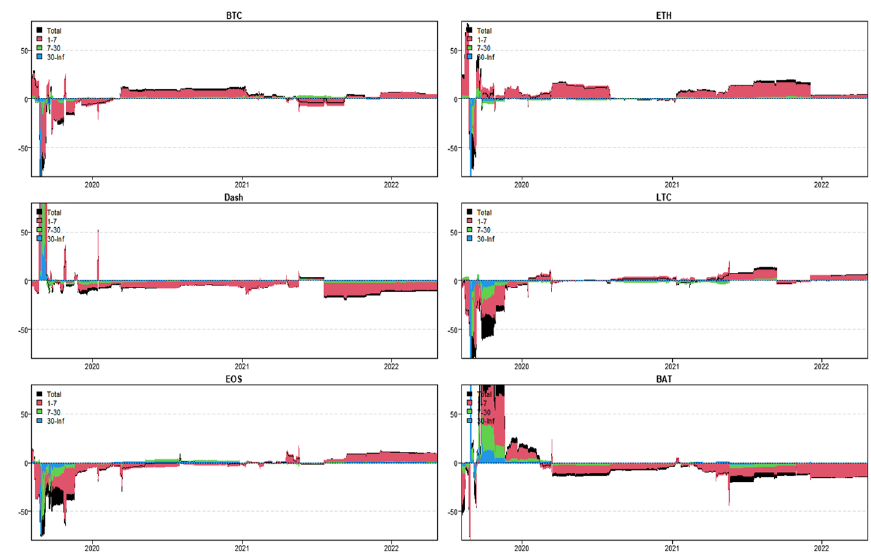
Fig. 14 Dynamic net connectedness—signed jump variation